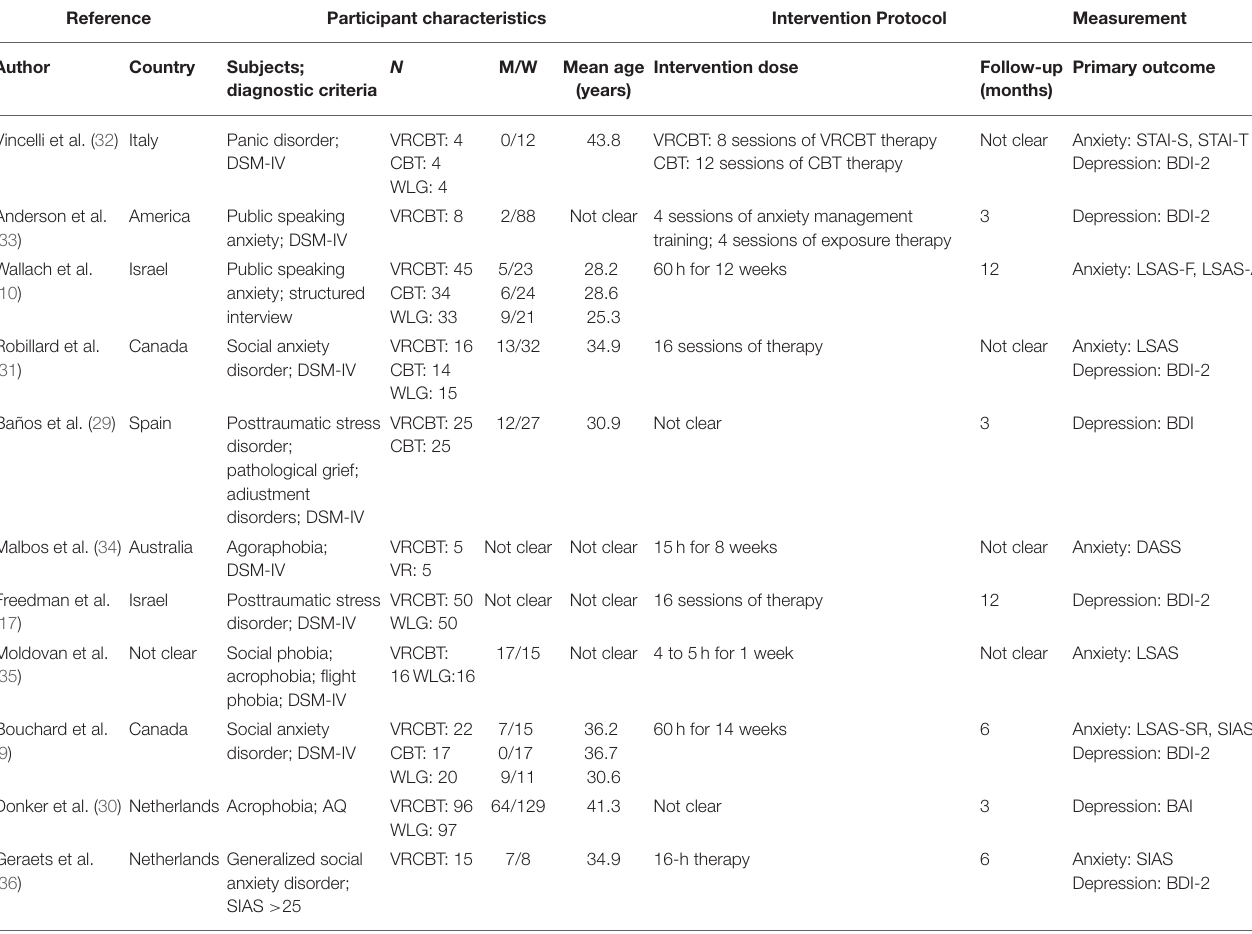
TABLE 2 | Study characteristics of eligible